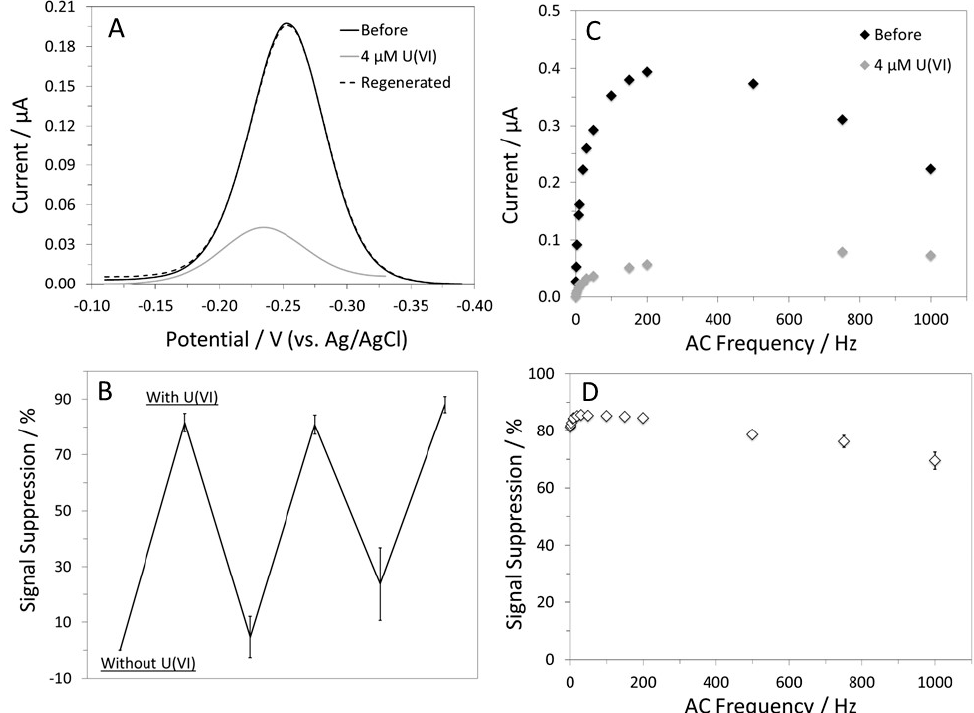
Figure 2. ( A ) ACVs of the U-pT-12 sensor recorded at 10 Hz in a Phys2 buffer. ( B ) Sensor reusability plot. ( C ) AC frequency-dependent responses of the sensor and ( D ) %SS plot. The error bars are not visible because of the size of the data label.